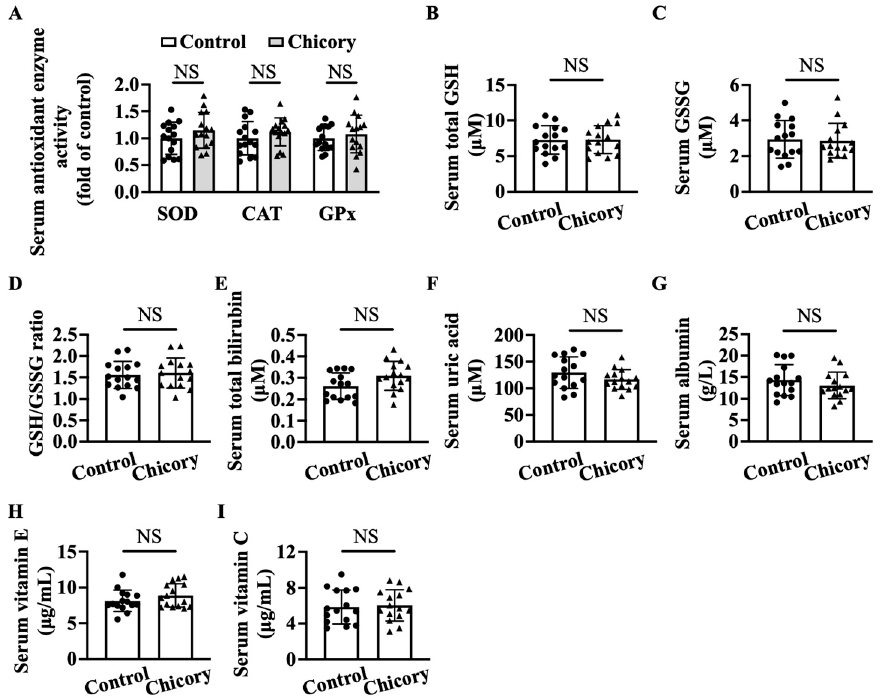
Figure 7. Brussels chicory does not alter enzymatic and non-enzymatic molecules with antioxidant function in the serum of Apoe − / − mice. ( A ) Antioxidant activities of serum superoxide dismutase (SOD), catalase (CAT), and glutathione peroxidase (GPx). ( B – I ) Total glutathione (GSH) ( B ) and oxidized GSH (GSSG) ( C ) content, the ratio of reduced GSH to GSSG ( D ), total bilirubin ( E ), uric acid ( F ), albumin ( G ), vitamin E ( H ), and vitamin C ( I ) in serum. Data are presented as means ± SD. n = 15. Scale bars: 100 μ m. Apoe, apolipoprotein E; Chicory, Brussels chicory. NS, nonsignificant ( p ≥ 0.05).